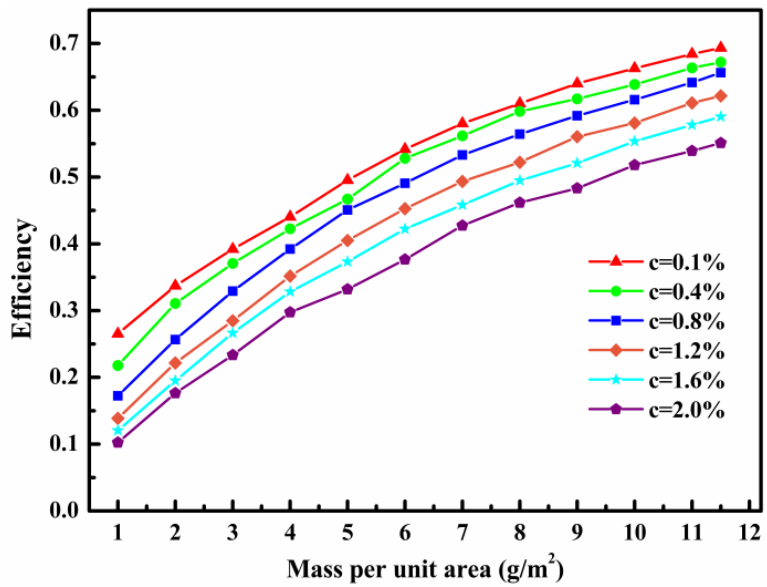
Figure 11. Effect of particle concentration on filtration efficiency.